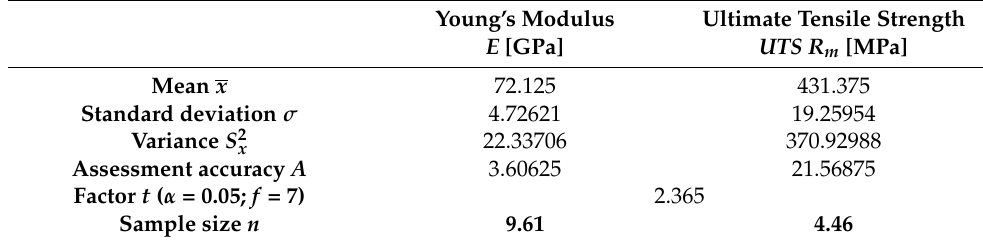
Table 2. Calculation of the sample size n in tensile tests.